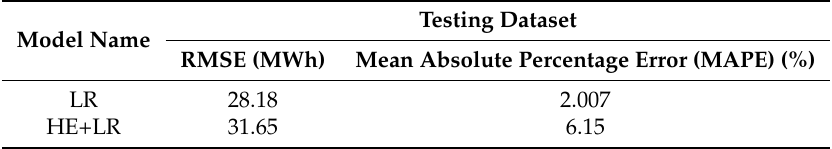
Table 4. HE for load forecasting problem—PJM